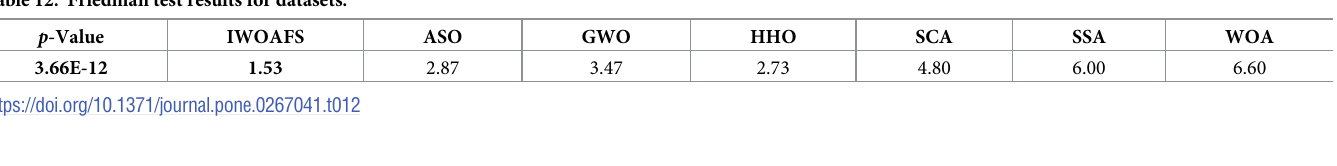
the selection of the least number of features on 5 datasets. The proposed method is slightly inferior to the ASO algorithm, but the difference between the two is not much. Therefore, it can be considered that the IWOAIKFS and ASO algorithm have the same advantages in the selection of the minimum number of features. However, if it is analyzed as a whole, the pro- posed method has better superior performance than the rest of the algorithms in this paper. In summary, analyzing from a single indicator, despite the effective results in some aspects, IWOAIKFS does not show the best search performance in all indicators, and the algorithm runs longer in experiments, causing certain limitations. Therefore, for IWOAIKFS and other meta-heuristic FS methods, the search and evaluation of the optimal feature subset should be changed according to the data set and actual needs to find the optimal feature subset in a spe- cific scenario.